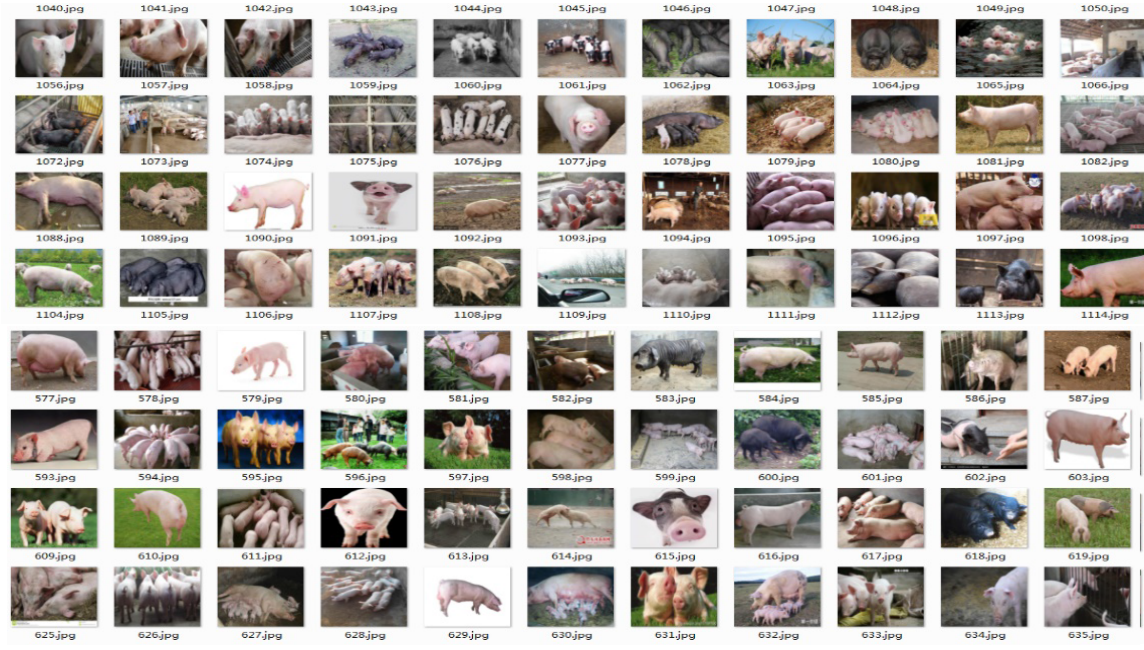
Fig. 1 Part dataset of this